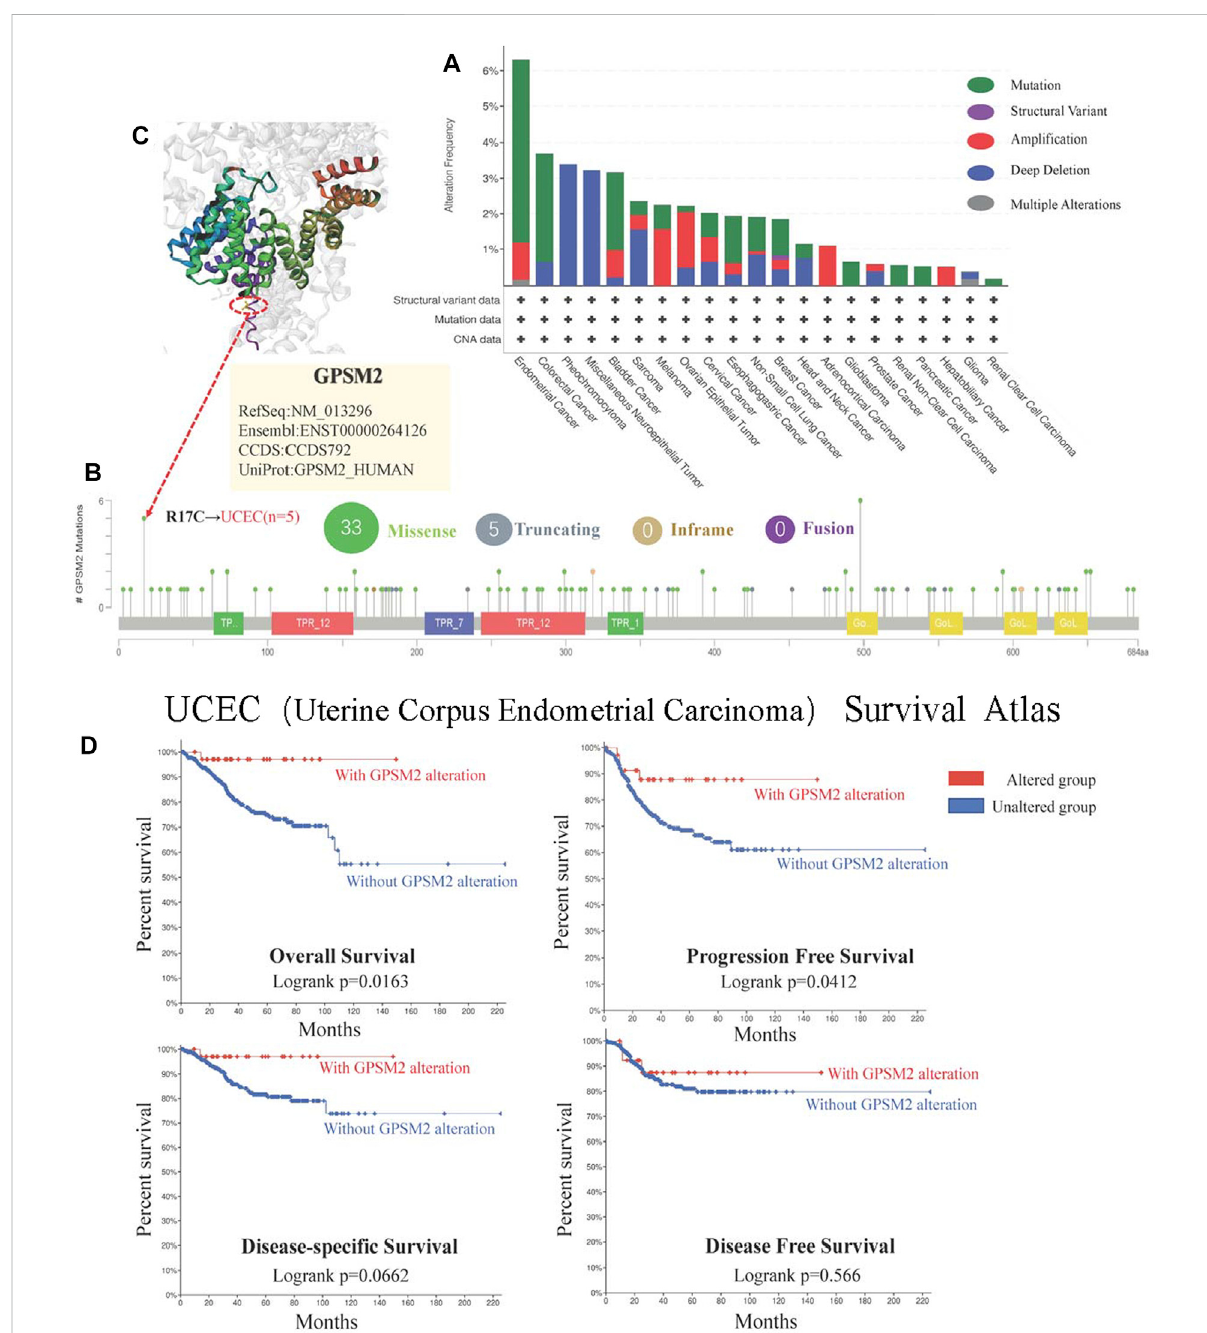
FIGURE 7 Mutations of GPSM2 in TCGA pan-cancer. (A) The mutation type and frequency of GPSM2 in tumors; (B) The change frequency of the GPSM2 gene structure and its mutation sites; (C) The position of the most frequent mutation site (R17C) in the 3D structure of the GPSM2 protein. (D) Correlation between UCEC with GPSM2 mutation and OS, DSS, DFS, and